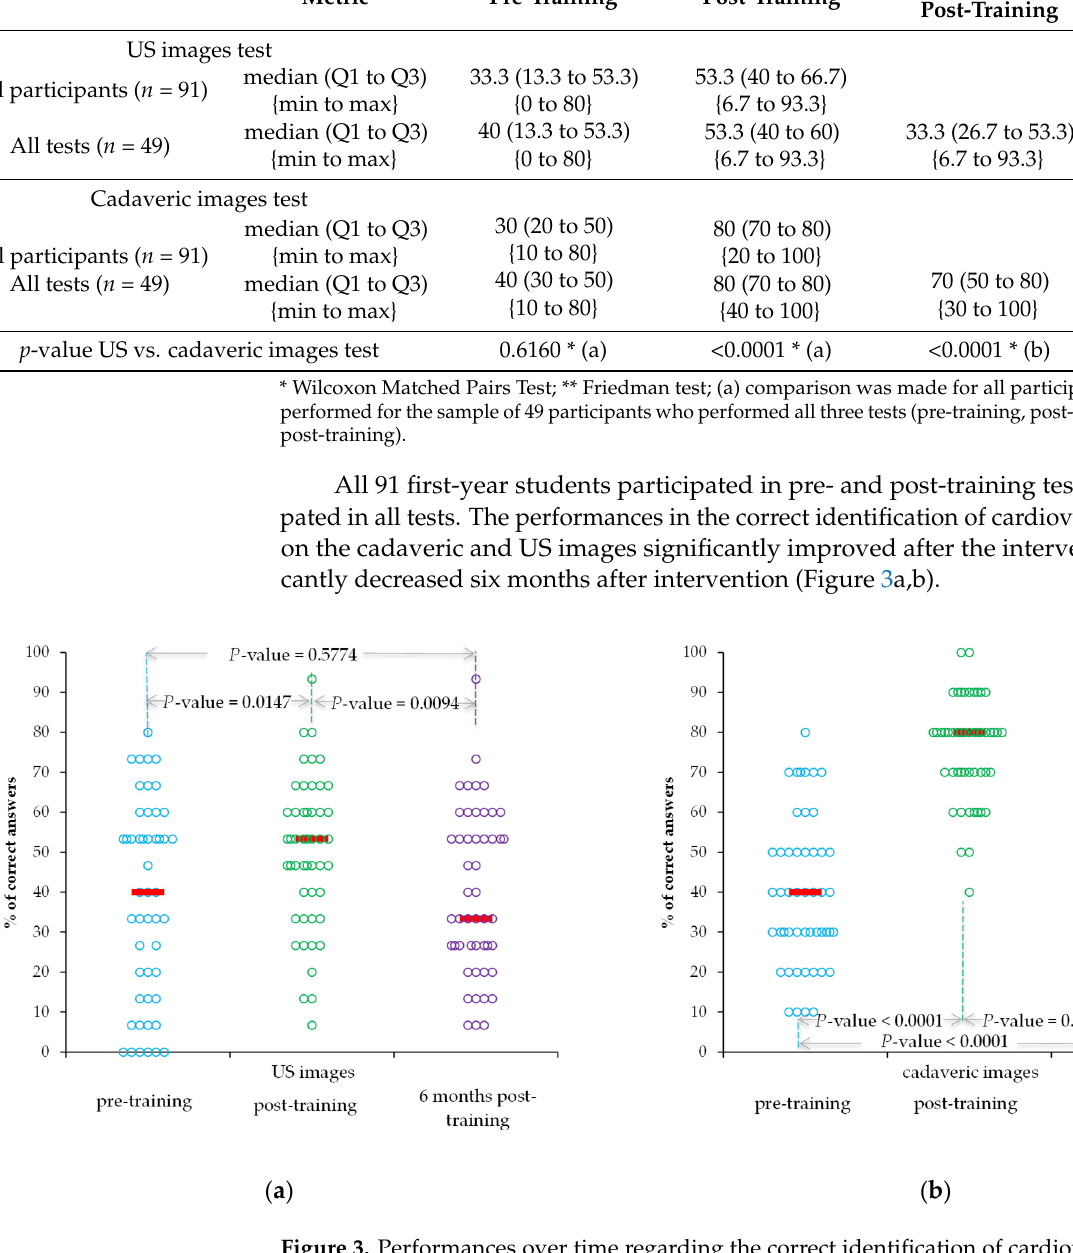
Figure 3. Performances over time regarding the correct identification of cardiovascular structures by students who sit to all three tests: ( a ) US images; ( b ) cadaveric images. Horizontal lines are the median values, and the circles are raw data.